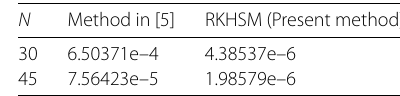
Table 5 Maximum absolute error for Example 5 ( n = 5) N Method in